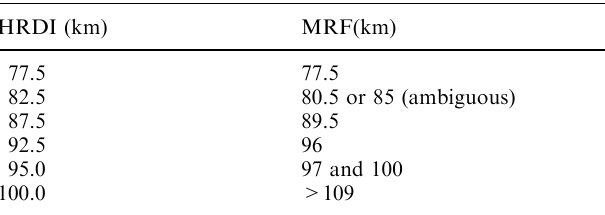
Table 2. Approximate best matching height based on direction- di(cid:128)erence medians HRDI (km) 77.5